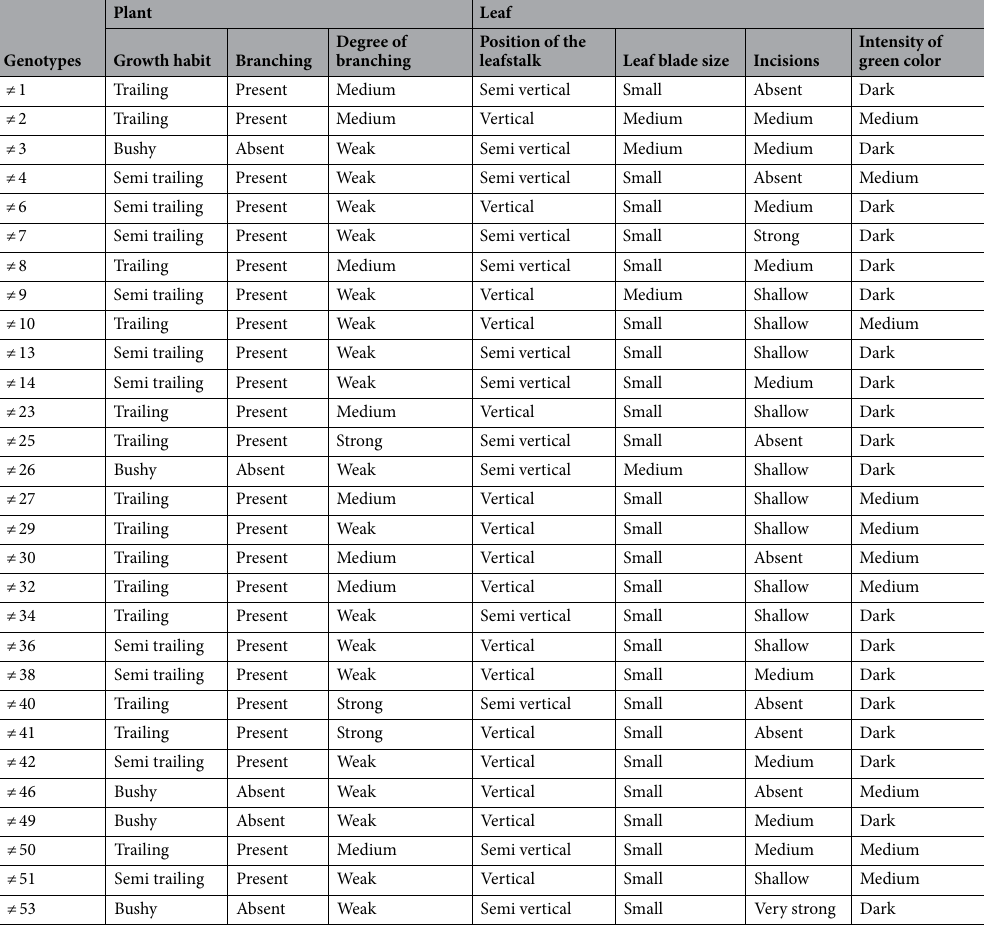
Table 3. Plant and leaf morphological parameters of pumpkin